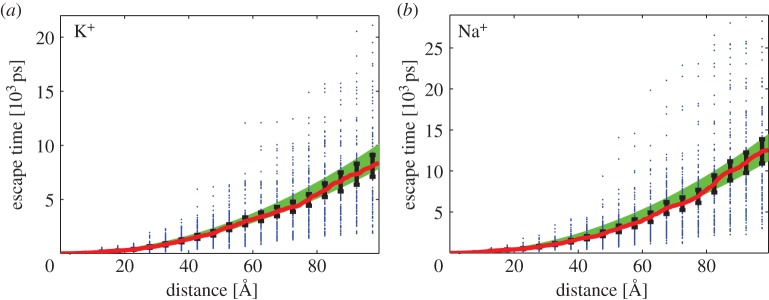
Escape time T(r) to reach distance r from the origin computed by the multiscale method. We consider (a) K+ ion; and (b) Na+ ion. We plot escape times for individual realizations (blue points), the mean escape time estimated from 100 realizations (red solid line) and the theoretical 95% confidence interval (6.4) (green area). We use ω=10 in (6.2).